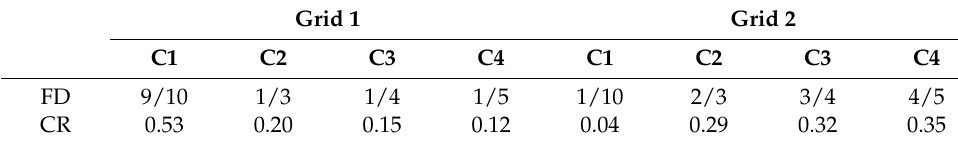
Figure 3. Illustration of point-of-interest (POI) semantics for functional regions. Table 1. POI frequency density (FD) and category ratio (CR) of Figure 3.